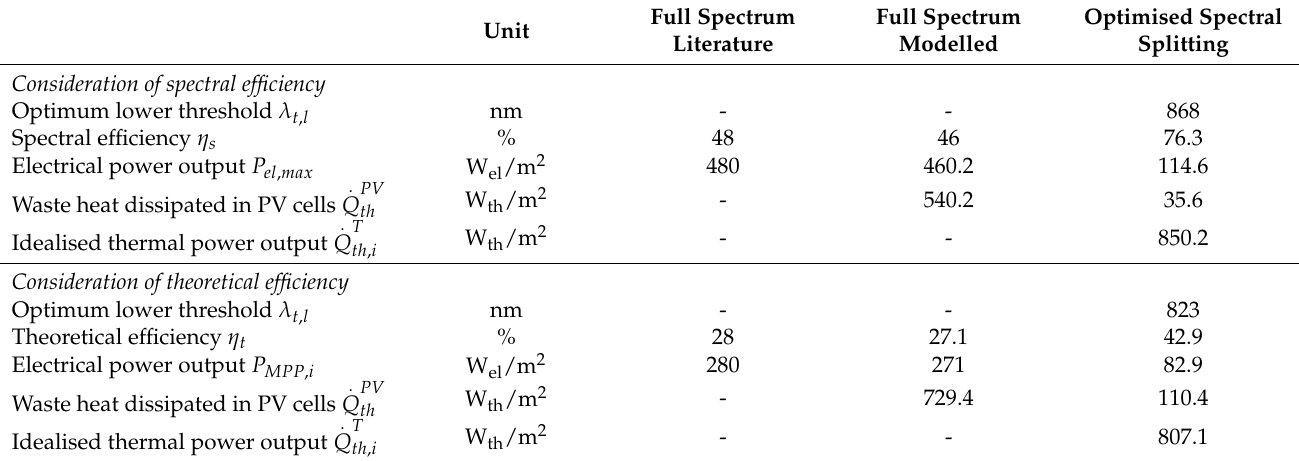
Table 2. Comparison of key parameters at full spectrum and at optimum Spectral Splitting configuration for CIGS PV technology.